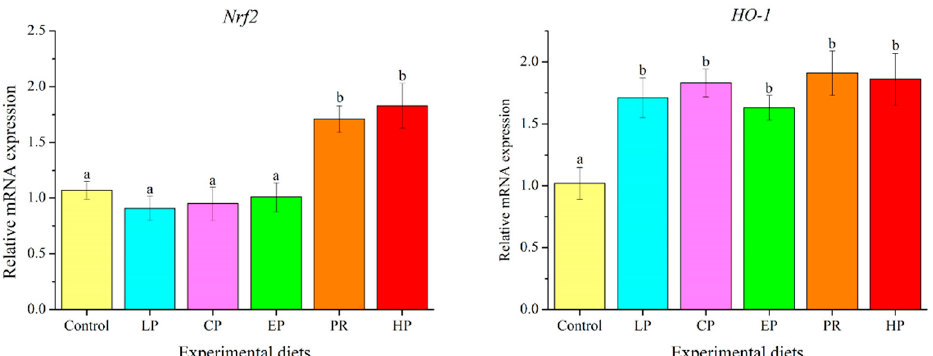
Figure 7. Effects of different diet treatments on the expression of antioxidant-related genes in the liver of Oncorhynchus mykiss . Values are presented as mean ± SE, n = 12. The superscript letters indicated significant differences at p < 0.05.